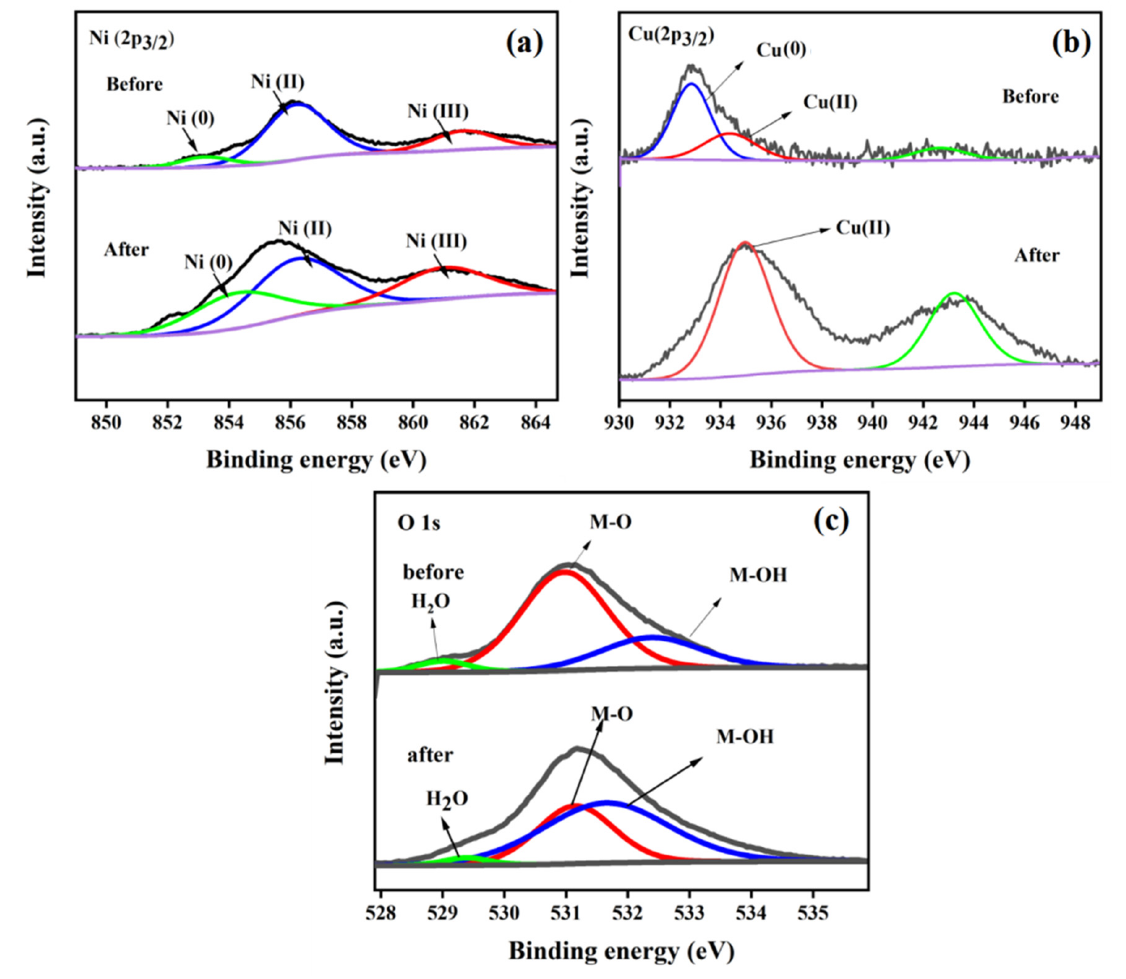
Figure 2. Comparison of XPS spectrum between NiCu ‐ NF electrode and NiCuOOH ‐ NF electrode: ( a ) Ni 2p, ( b ) Cu 2p, ( c ) O 1s.